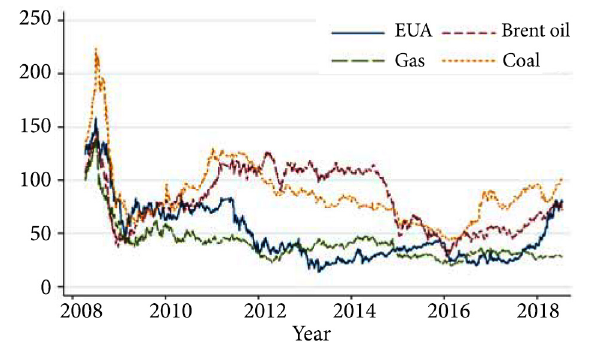
Figure 1. Daily prices of the EUA and the